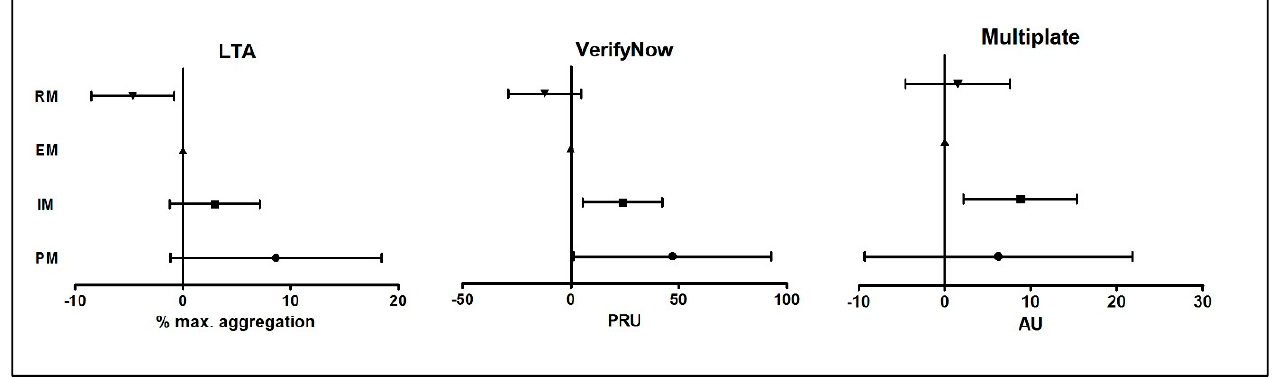
Figure 2. Different metabolizer groups as predictor of residual platelet reactivity in multivariate linear regression analysis. Partial regression coefficients (B) with 95% confidence interval for metabolizer group as predictor of residual platelet reactivity as measured by the 3 platelet function tests. Extensive metabolizers (EM) are the reference group. Abbreviations: PM, poor metabolizer; IM, intermediate metabolizer; EM, extensive metabolizer; RM, rapid metabolize. Max. aggregation, percentage of maximum aggregation; PRU, P2Y12 reaction units; AU, aggregation units.